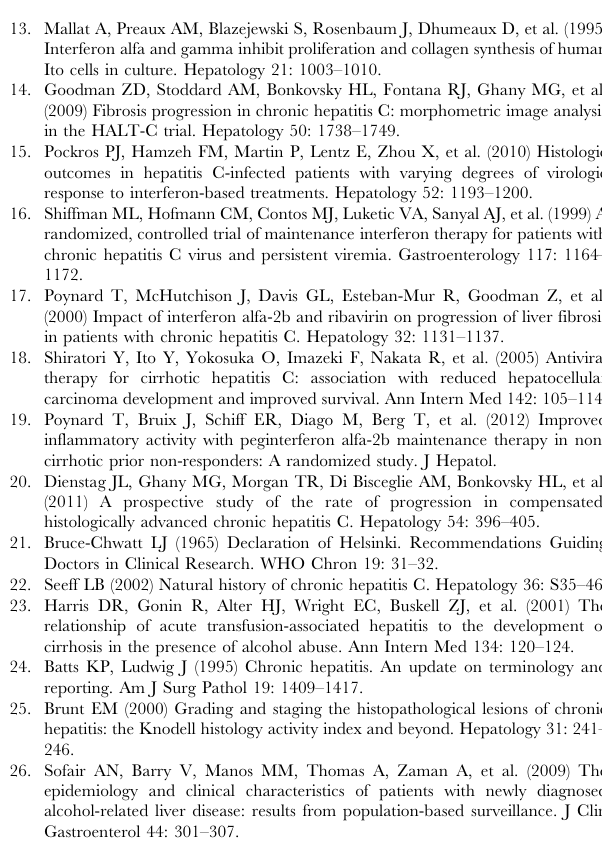
Table S2 Risk Factors of Treated and Untreated Patient Groups (UCSF Cohort). Table S3 Predictors of Development of Cirrhosis Strat- ified by Fibrosis Stage (UCSF Cohort). Table S4 Predictors of Death or Liver Transplant Stratified by Fibrosis Stage (UCSF